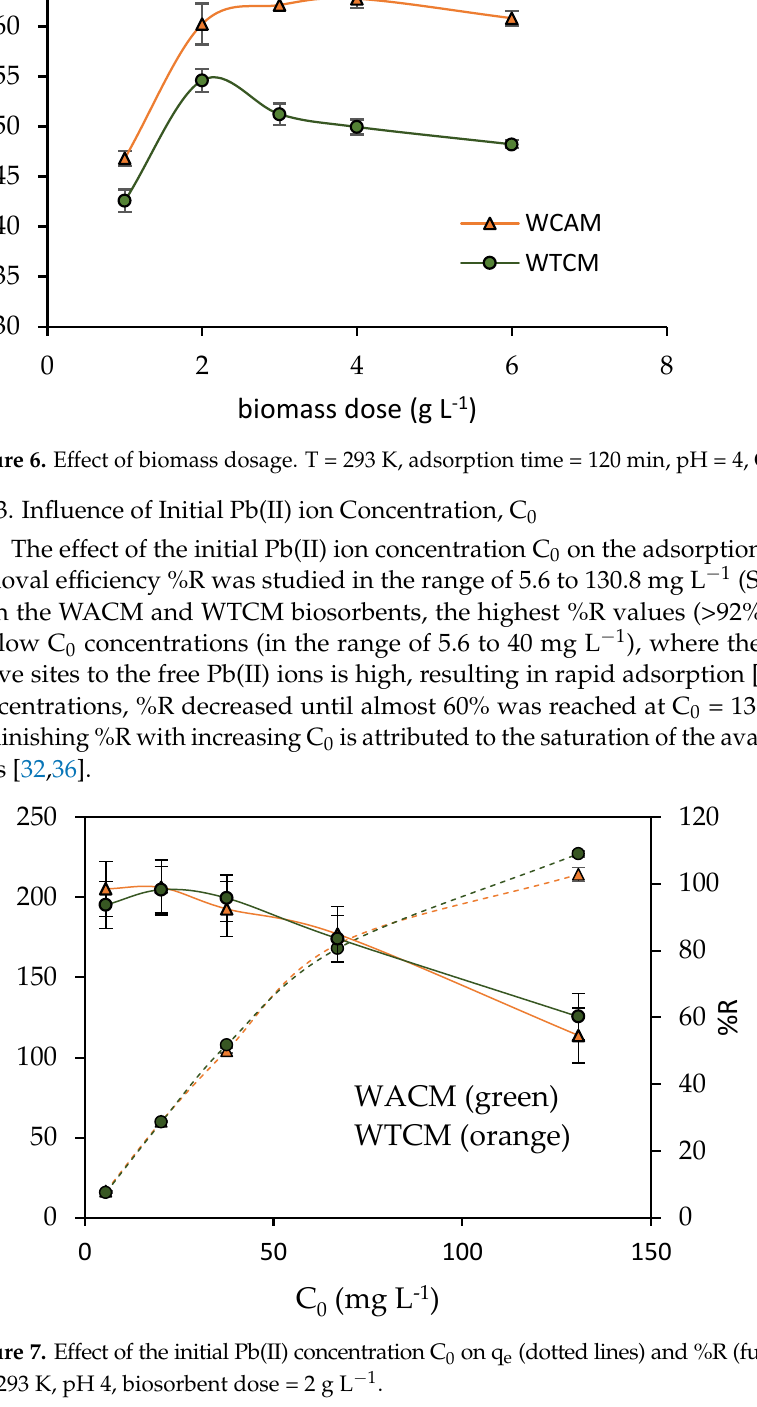
6 of 16 Figure 5. Influence of pH on the Pb(II) adsorption capacity, q e , for T = 293 K, adsorption time = 120 min, biosorbent dose = 2 g L  1 , C 0 = 130.8 mg L  1 . 2.3.2. Influence of Biomass Dosage Figure 6 depicts the Pb(II) removal efficiency, %R, as a function of the biomass dosage. A significant increase in %R is observed for both the WACM and WTCM biosorbents, reaching almost 55% and 60%, respectively, for a biomass dosage of 2 g L −1 . A further increase in the dosage produces a slight increase in %R for WTCM but a rapid decrease for WACM. The latter trend is due to the agglomeration of the WACM biomass, observed during the experimentation, which would reduce the effective surface area available for